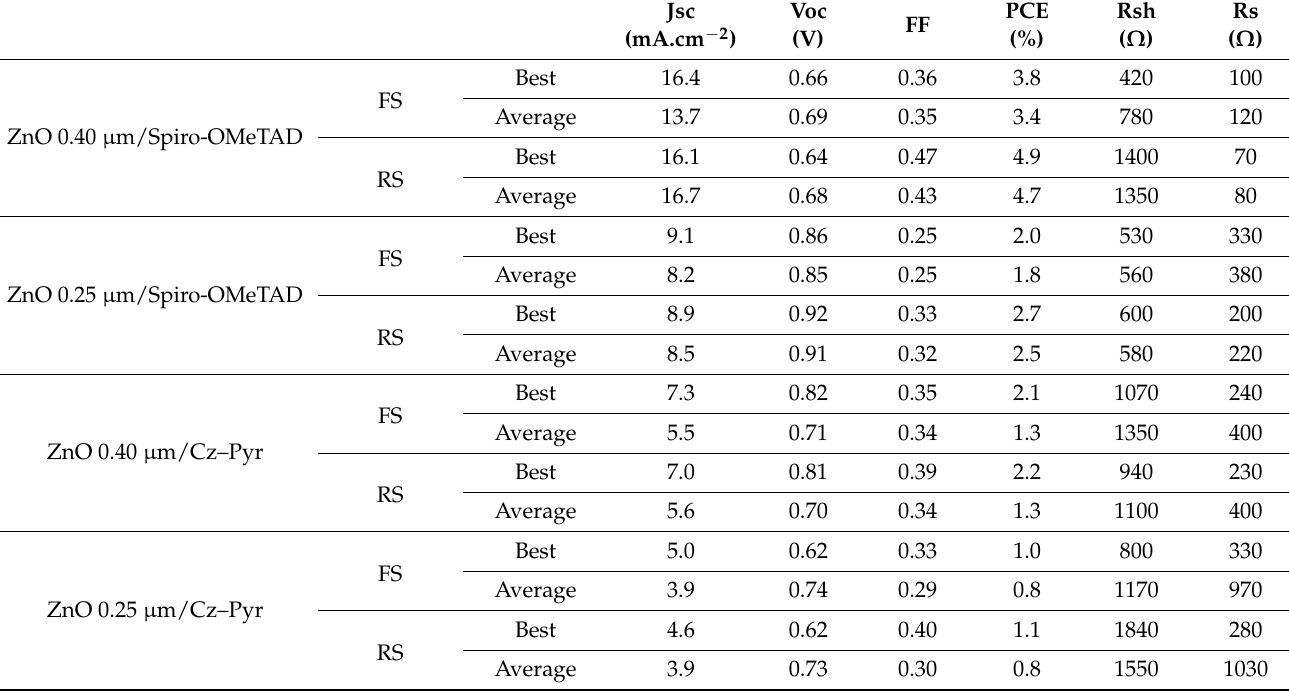
Table 8. Performances of perovskite solar cells fabricated with different NW-based ETLs (ZnO 0.40 µ m and ZnO 0.25 µ m) and HTLs (i.e., spiro-OMeTAD and